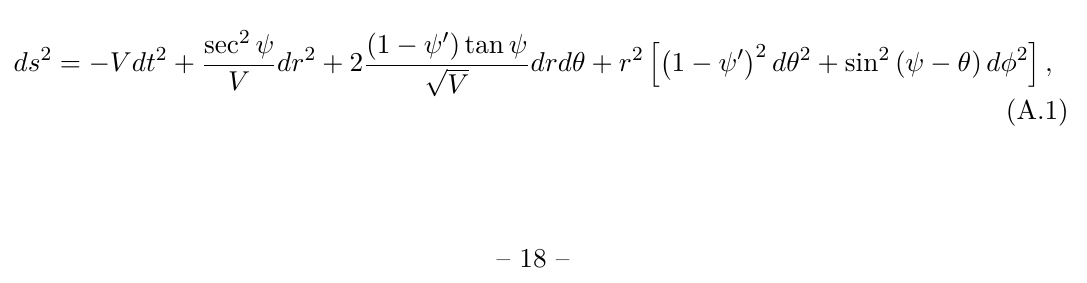
JHEP09(2022)117